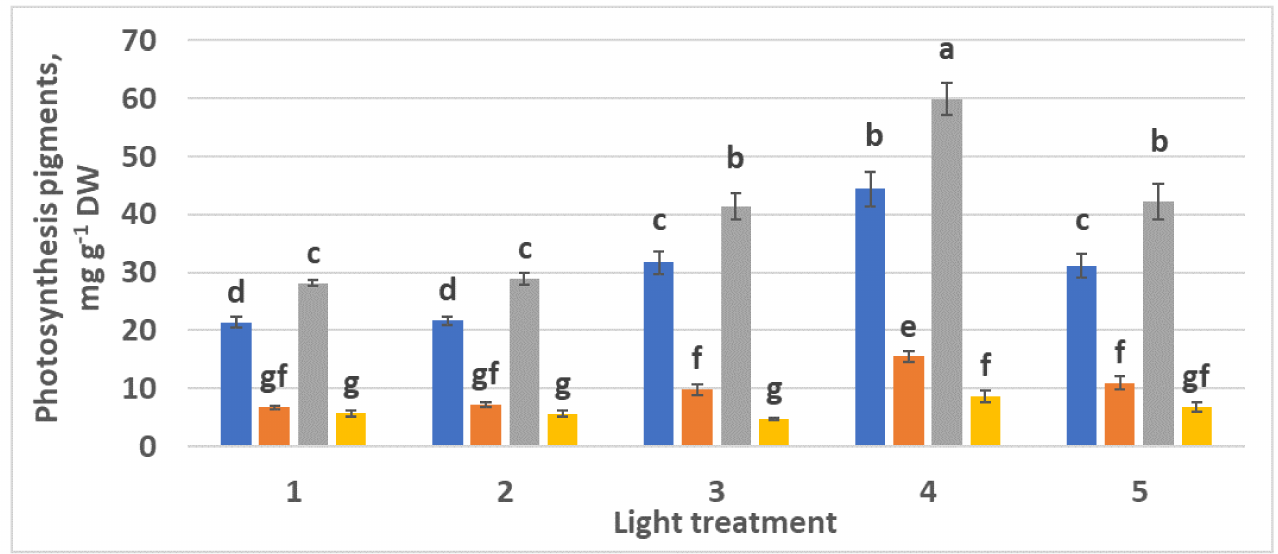
Figure 13. Chlorophylls and carotenoids content in the leaves of raspberry plants grown under various red (R)–green (G)– blue (B) light ratio. Means ± standard error (SE); means followed by the same letter were not different at p ≤ 0.05. Treatment 1—50% R, 25% G, 25% B; Treatment 2—37% R, 26% G, 37% B; Treatment 3—24% R, 28% G, 48% B; Treatment 4—63% R, 16% G, 21% B; Treatment 5—46% R, 30% G, 23%